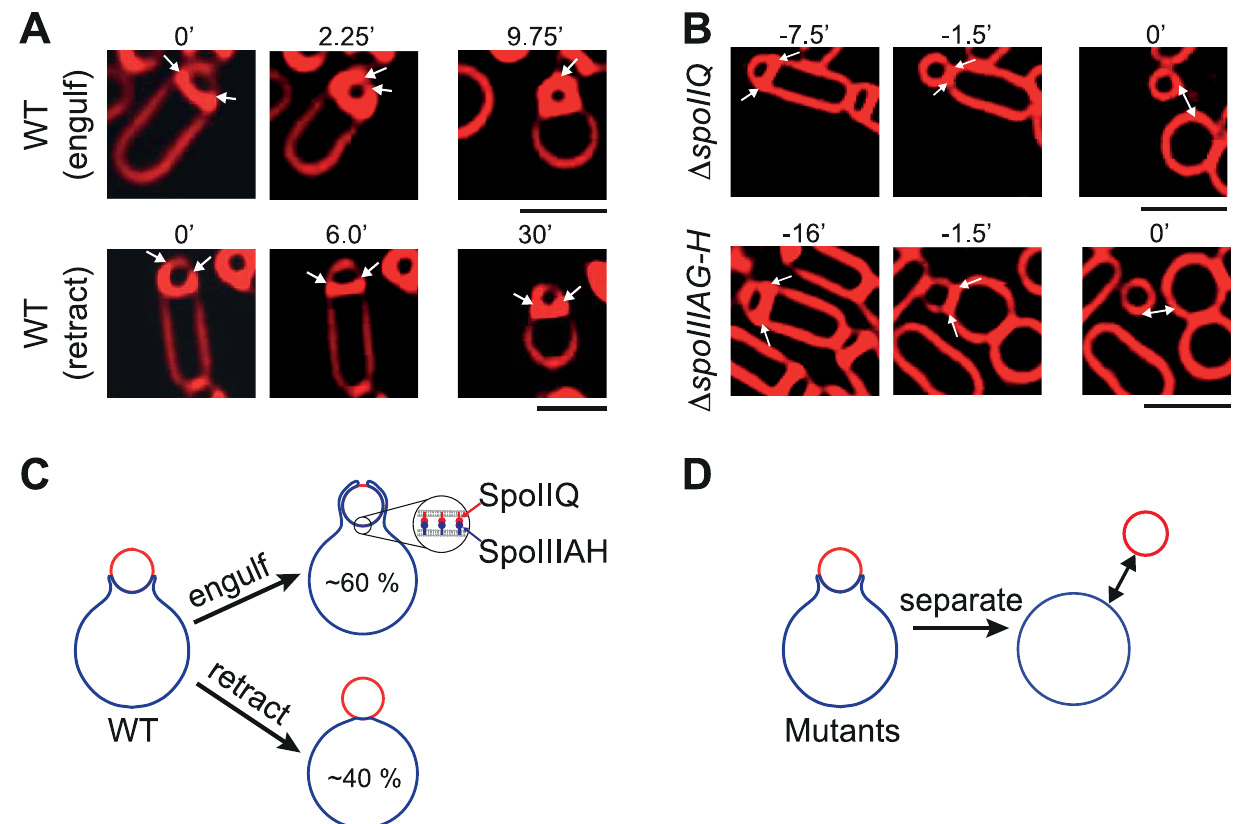
Figure 1. Bistable forespore engulfment of B.subtilis after cell-wall removal. (A and B) Images adopted from [8]. Medial focal plane images of sporulating bacteria treated with cell-wall removal lysozyme in osmotically protected medium with 0.5 M of sucrose [8]. Fluorescent membrane stain FM 4–64 was used to track the progressing mother-cell membrane engulfing the forespore. Arrows point to the moving edges of the mother membrane. Double-headed arrows show mother-forespore cell separation. (A) In wild-type (WT) cells upon cell-wall removal, mother cell either engulfs the forespore (top) or retracts (bottom), see Movie S1. Time 0 minutes (0’) is assigned to the onset of volume loss (see Fig. 2A). (B) Absence of the zipper proteins SpoIIQ (top) or SpoIIIAH (bottom) prevents membrane from forward progression causing protoplast separation. Time 0 minutes is used as the time of physical separation of mother cell and forespore. (C) Cartoon of fast bistable forespore engulfment in WT cells. Mother-cell compartment and forespore are shown in blue and red, respectively. After cell-wall removal * 60 % of the sporulating cells engulf the forespore, while * 40 % fail to engulf [8]. (D) Cartoon showing the protoplast separation as observed in mutants of panel B. Scale bars: 2 m m.